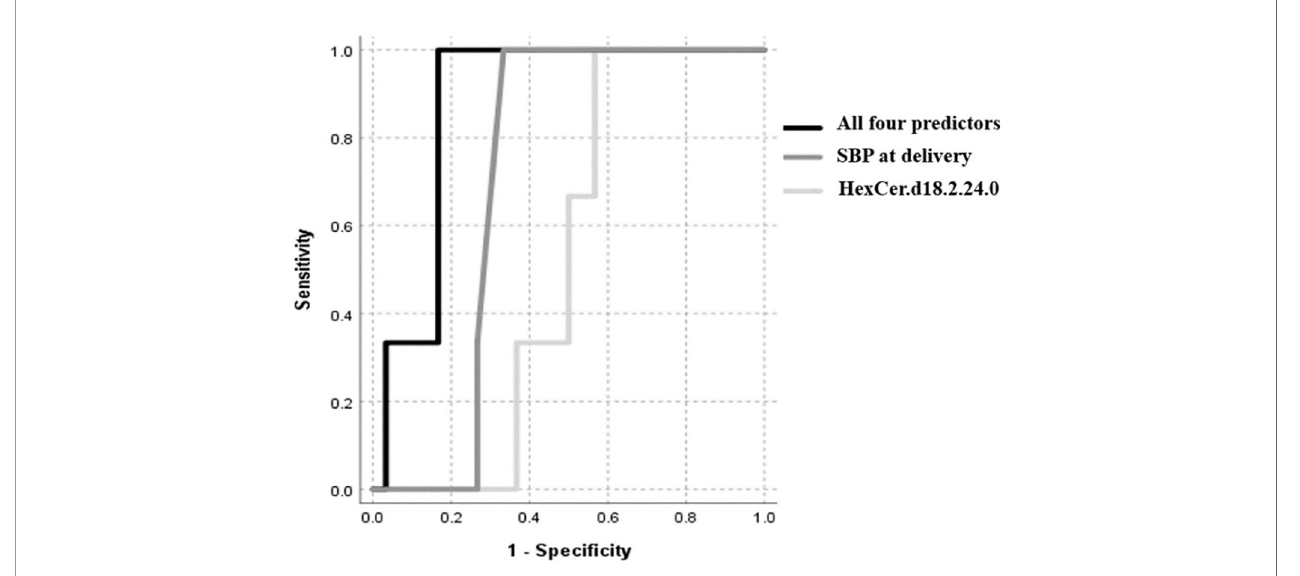
FIGURE 4 | ROC curve of low birth weight ( ≤ 2500 grams), including maternal SBP at delivery, HexCer.d18.2.24.0, Cer.d18.0.24.1 and